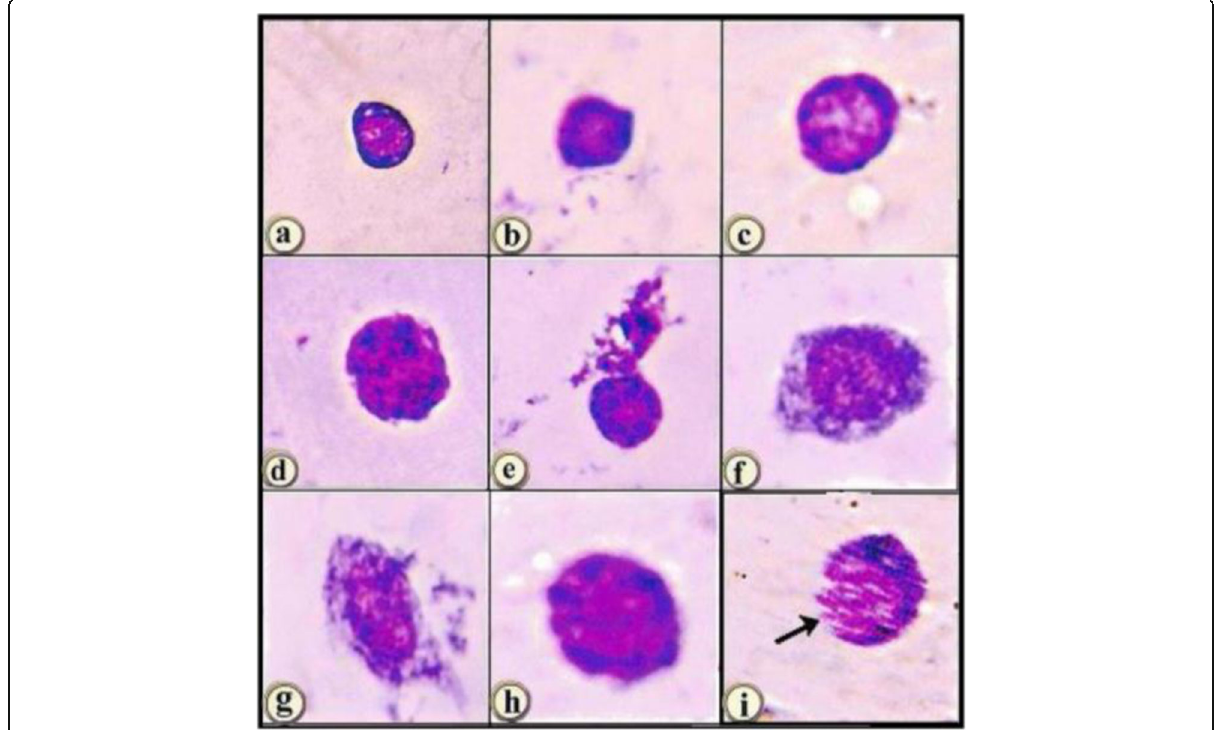
Fig. 2 Morphological changes in prohemocytes ( x = 1600). a Normal: small, round to slightly ovoid prohemocyte cell. b 40 Gy, c 100 Gy, d BA2 40 IJs/ml, e 40 Gy + BA2 20 IJs/ml, f 100 Gy + BA2 20 IJs/ml, g 40 Gy + BA2 40 IJs/ml, h 100 Gy + BA2 20 IJs/ml, and i 100 Gy + BA2 40 IJs/ml: destruction of the cell membrane and presence of vacuoles